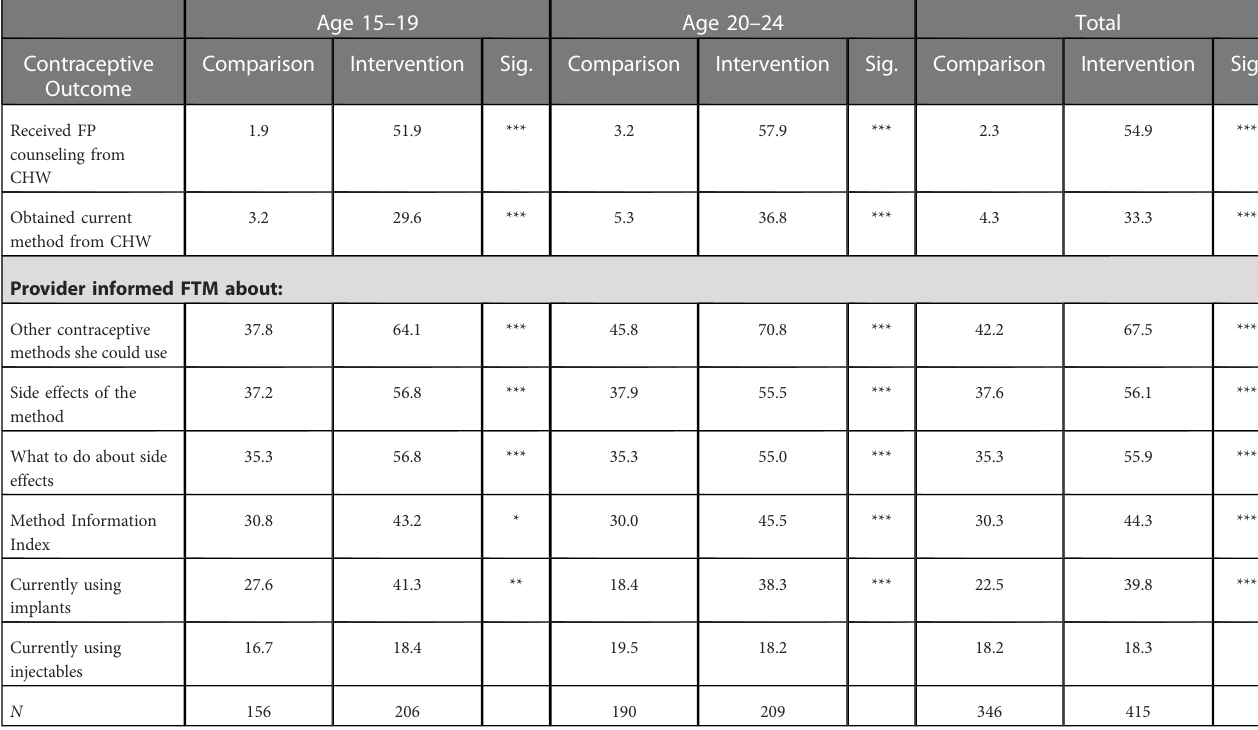
TABLE 2 Percentage of modern contraceptive users age 15 – 24 with selected contraceptive outcomes, by age group and health zone, fi rst-time mothers, Kinshasa. Age 15 – 19 Contraceptive Comparison Intervention Outcome